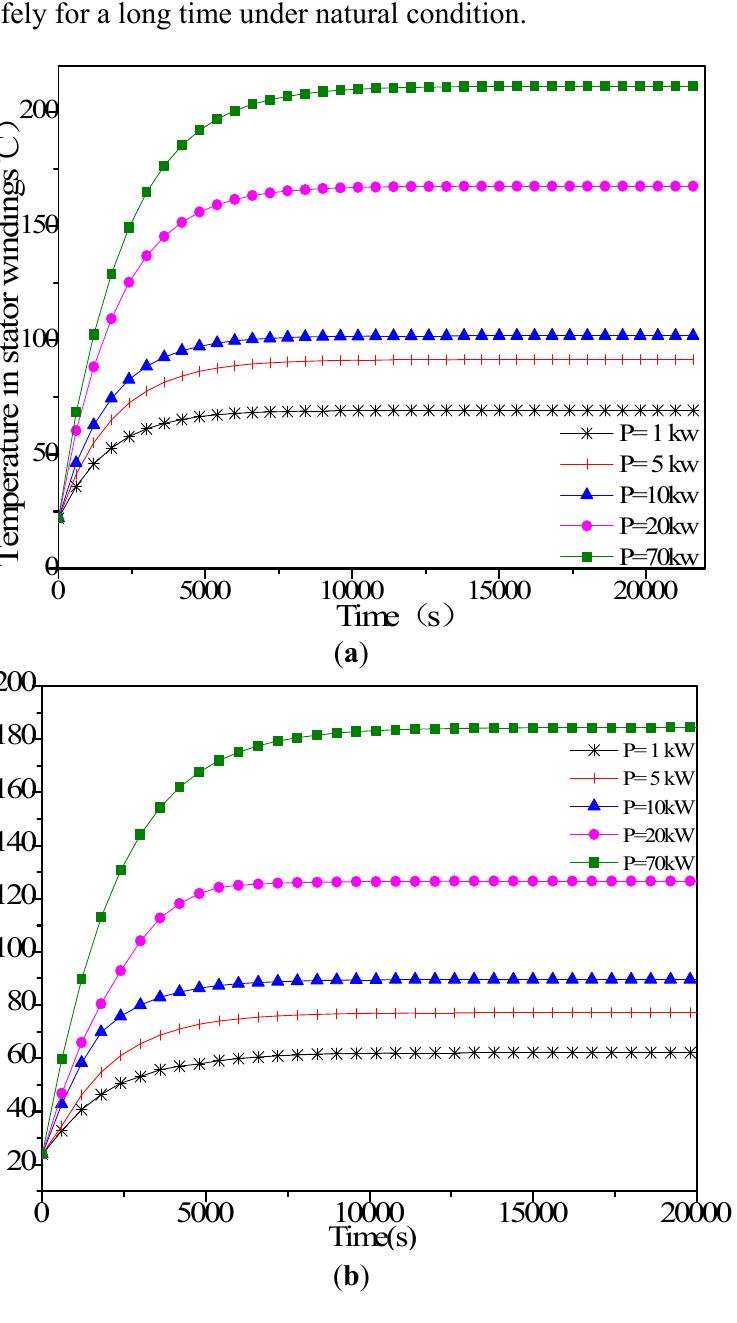
Figure 13. Temperatures versus time under natural condition: ( a ) in stator windings; and ( b ) in